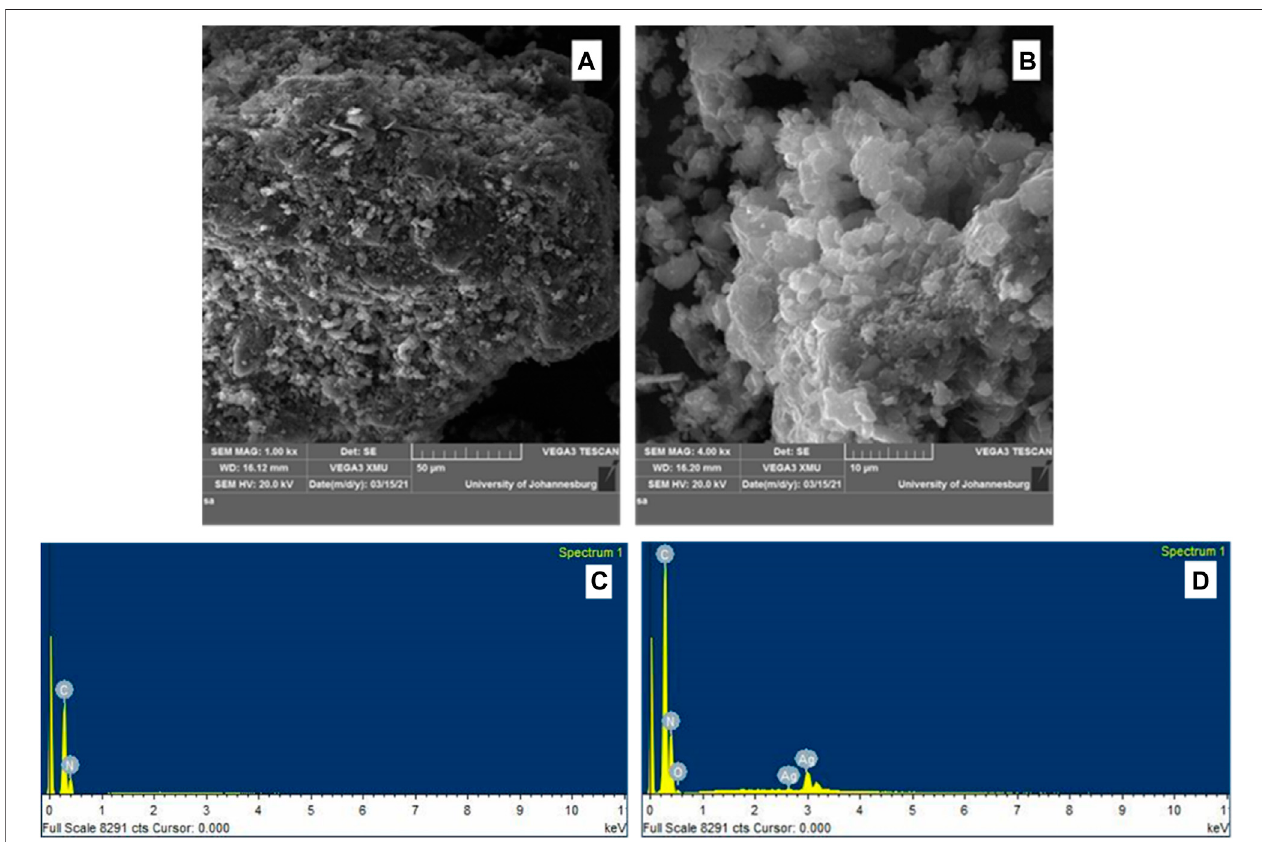
FIGURE 2 | FESEM micrographs of (A) gCN, (B) gCN-AgPVP, and EDX spectrum of (C) gCN and (D) EDX spectrum gCN-AgPVP.